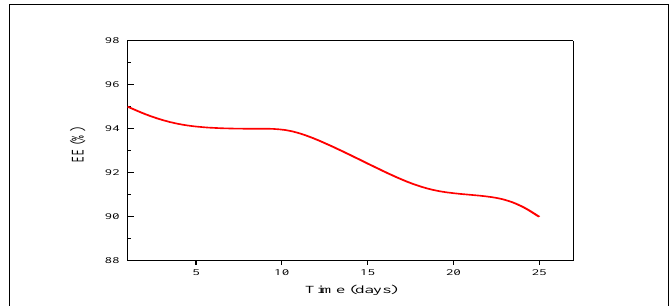
Figure 3: Encapsulation efficiency